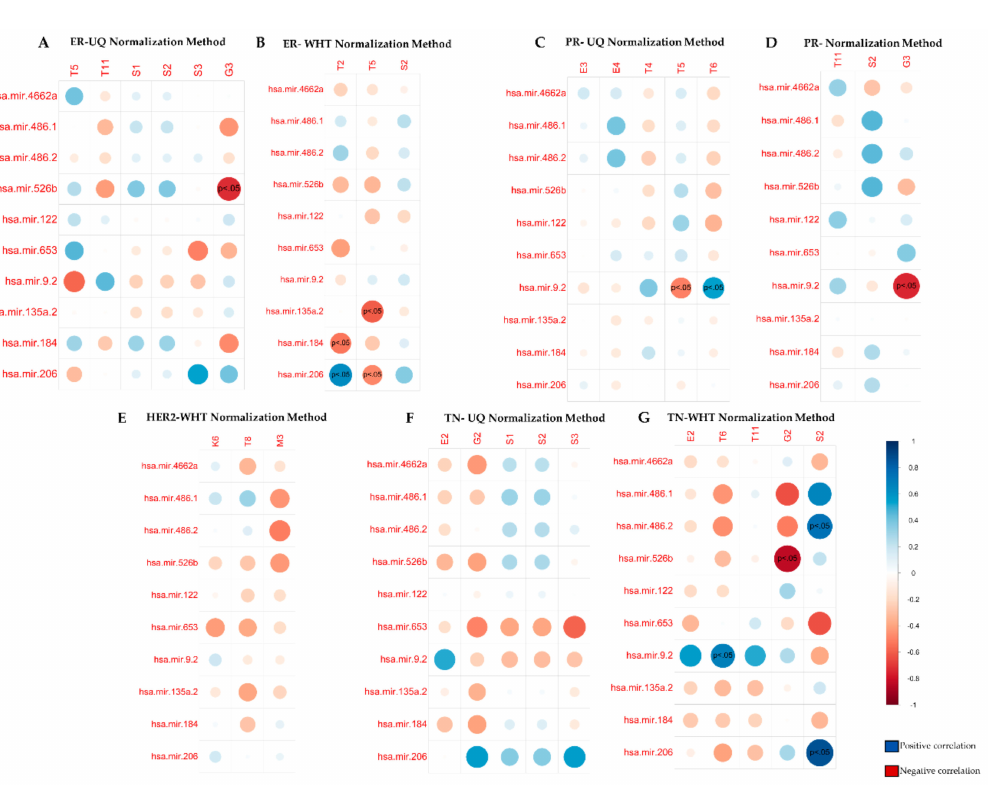
Figure 4. Spearman correlation between miRNAs expression and MRI radiomic features normalized by Upper Quartile and Whitening methods for molecular receptor status. ( A ) Correlation between ER negative breast cancer miRNAs expression and MRI radiomic features normalized by Upper Quartile (UQ) method. ( B ) Correlation between ER negative breast cancer miRNAs expression and MRI radiomic features normalized by Whitening (WHT) method. ( C ) Correlation between PR negative breast cancer miRNAs expression and MRI radiomic features normalized by Upper Quartile (UQ) method. ( D ) Correlation between PR negative breast cancer miRNAs expression and MRI radiomic features normalized by Whitening (WHT) method. ( E ) Correlation between HER2 positive breast cancer miRNAs expression and MRI radiomic features normalized by whitening methods. ( F ) Correlation between TN negative breast cancer miRNAs expression and MRI radiomic features normalized by Upper Quartile (UQ) method. ( G ) Correlation between TN negative breast cancer miRNAs expression and MRI radiomic features normalized by Whitening (WHT)